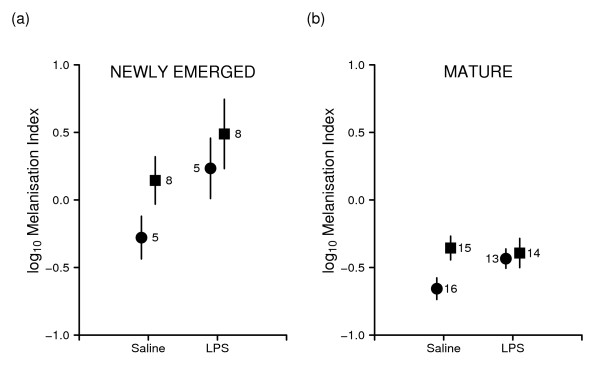
Mean melanisation index (± 1 SE) for males (circle) and females (square) of (a) newly emerged and (b) mature Enallagma boreale 12 h after injection of saline or LPS and held at 22°C. Melanisation index values provide an indication of Phenoloxidase (PO) activity i.e. higher values indicates higher PO activity. Numbers indicate sample size.